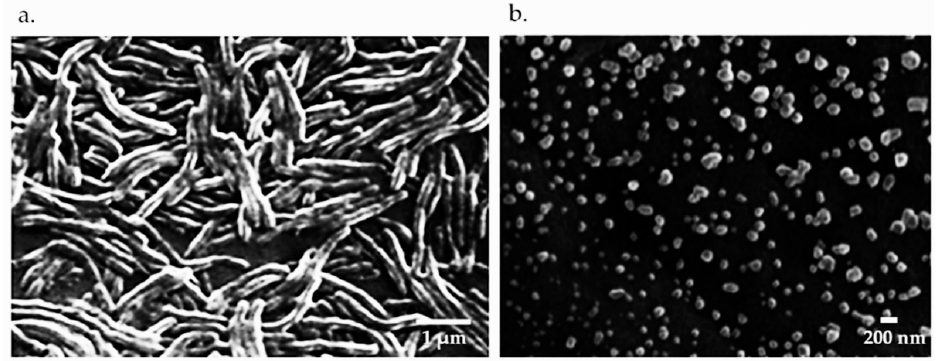
Figure 2. ( a ) Scanning electron microscopy (SEM) of the surface morphology of formalin killed vaccines, Scale bar = 1 µ m. and ( b ) SEM images of CS-NE vaccine, scale bar = 200